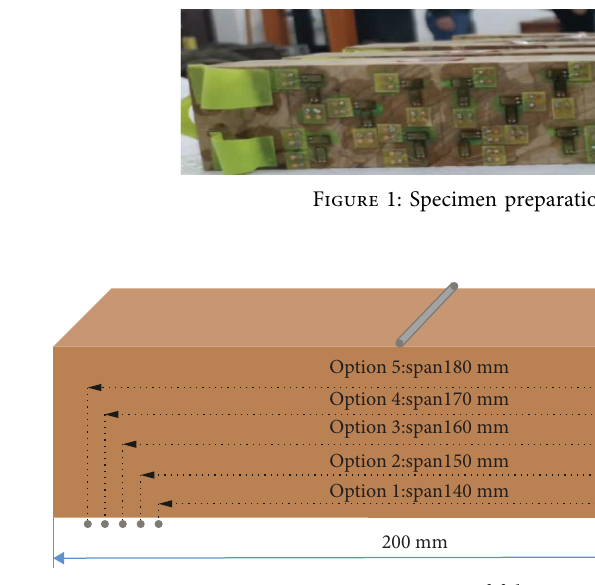
Figure 2: Layout of fulcrum span.